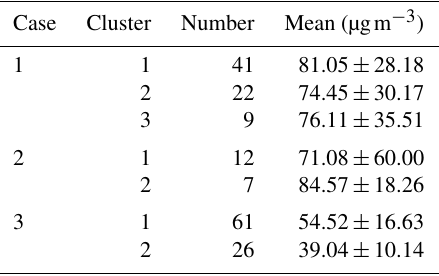
Table 1. Trajectory number and PM mean concentration of each cluster in Hangzhou during three cases, including case 1 (trans- portation from haze area of North China), case 2 (transportation from northwestern dust area), and case 3 (transportation from south- ern biomass-burning